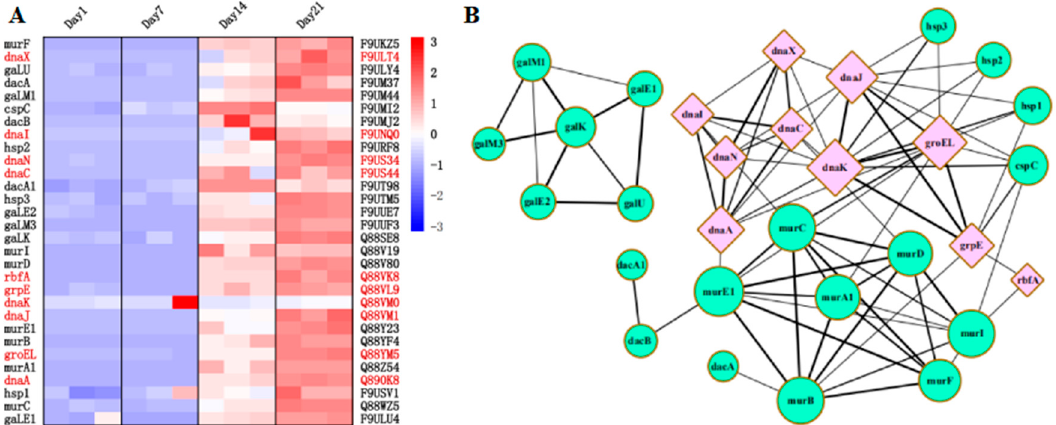
Figure 6. Quantitative analysis of differentially expressed acid-resistant and low-temperature-resistant proteins in Lpb. plantarum NMGL2 in fermented milk stored at low temperature (4 °C) for days 1, 7, 14, and 21 ( A ), using String software to visualize the different proteins on the network ( B ).